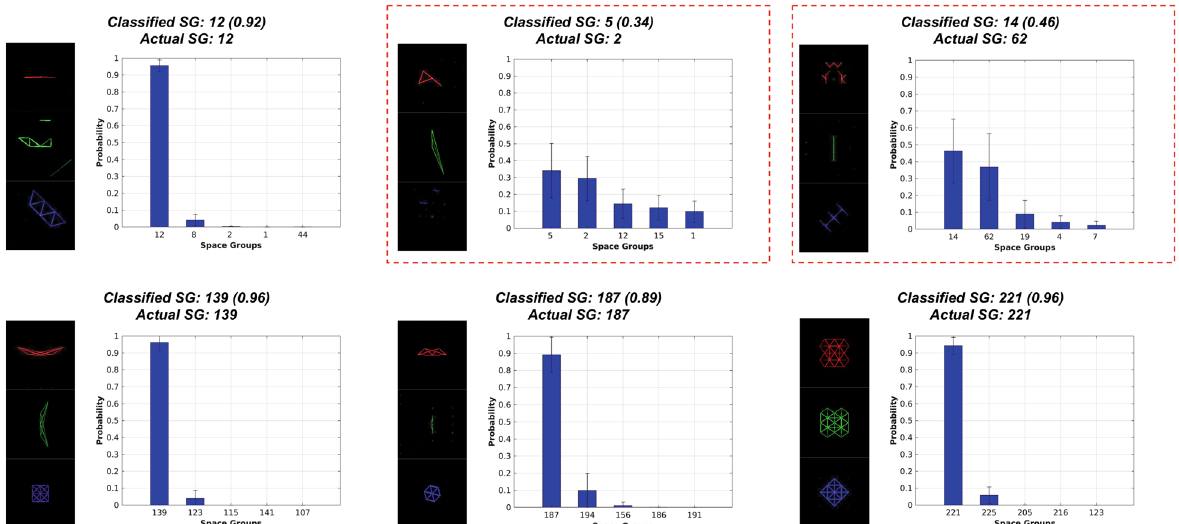
Fig. 4 Probabilistic classi fi cation examples. Six examples are randomly selected from the 72 SG test dataset. Each example is shown with the bar graph where the top-5 classi fi cation probabilities are shown with the standard deviations. The probabilities are computed via 500 passes of each image with MC dropout active. The probability of the most likely solution is shown in the parentheses in each example. Misclassi fi ed images are highlighted by the red dotted box.